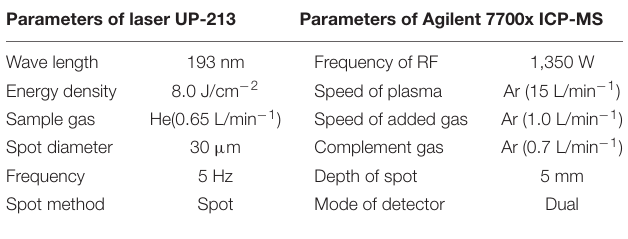
TABLE 2 | Analytical parameters of laser ablation inductively coupled plasma mass spectrometry (LA-ICP-MS). Parameters of laser